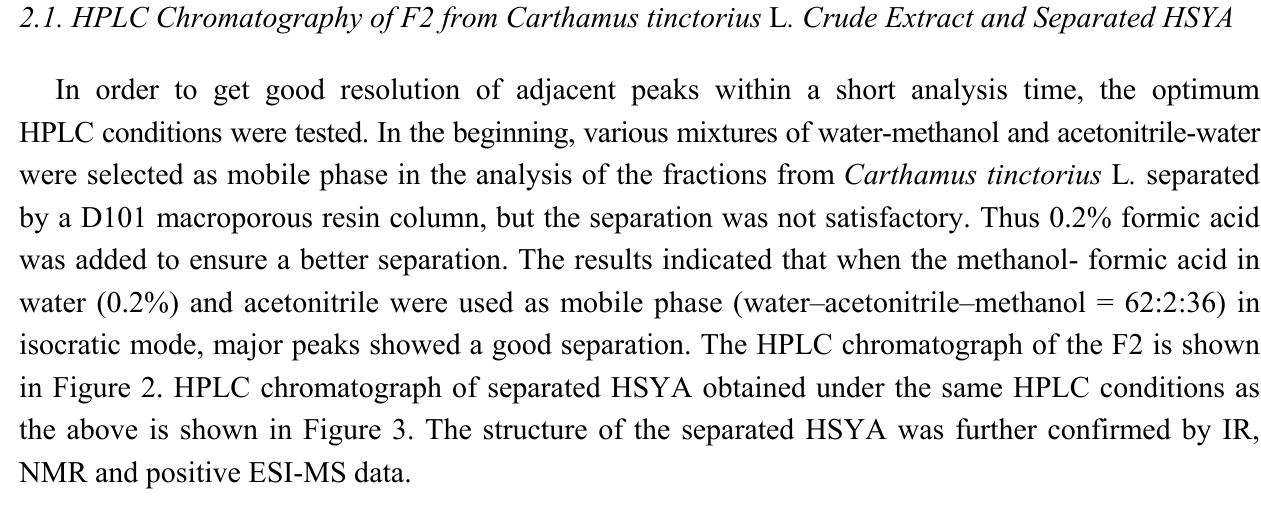
Figure 2. The HPLC chromatograph of the second fraction (F2) of crude extract from Carthamus tinctorius L. flowers obtained from a macroporous resin column. Conditions: column: ODS C (250 mm × 4.6 mm I.D., 5 μ m); mobile phase: 0.2% formic acid in water 18